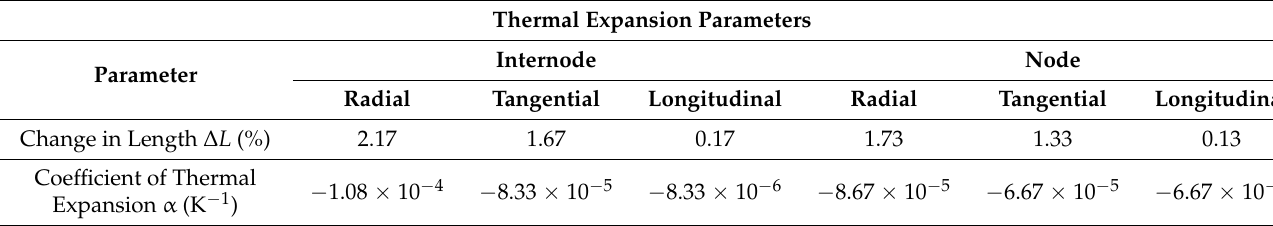
Table 3. Thermal expansion parameters used in FEM simulation.